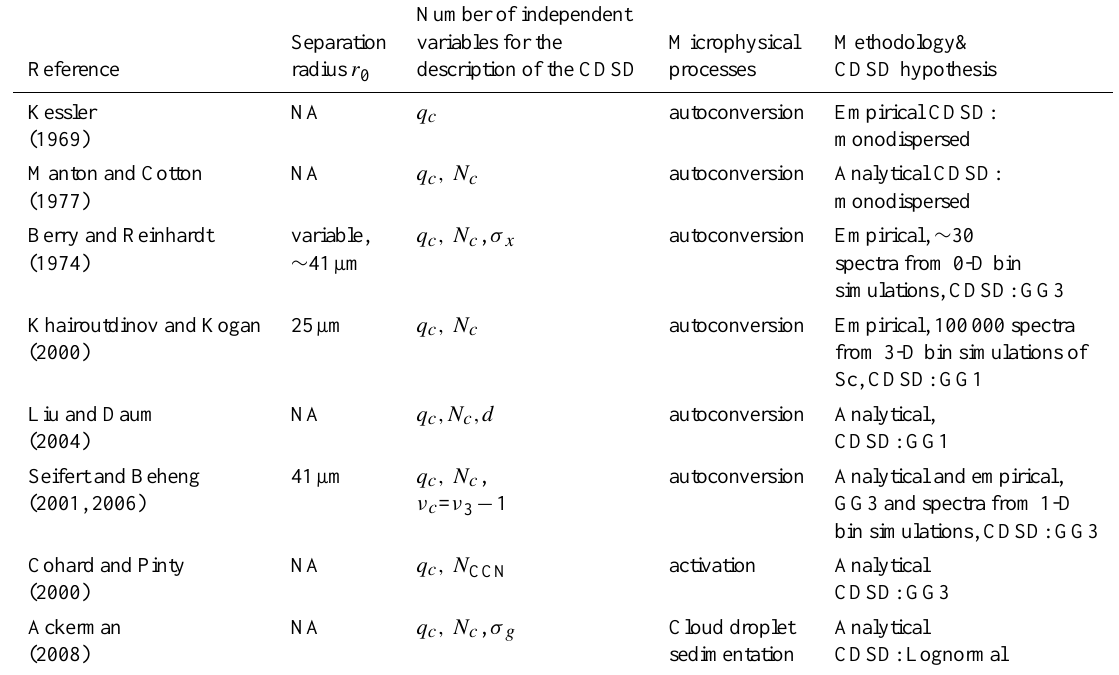
Table 1. Typical bulk parameterizations using two particle categories with, from left to right, the value of the threshold radius between the two categories, the number of independent variables for the description of the droplet size distribution (CDSD), the parameterized microphysical processes, the methodology adopted for the development of the parametrization, and the CDSD parametric